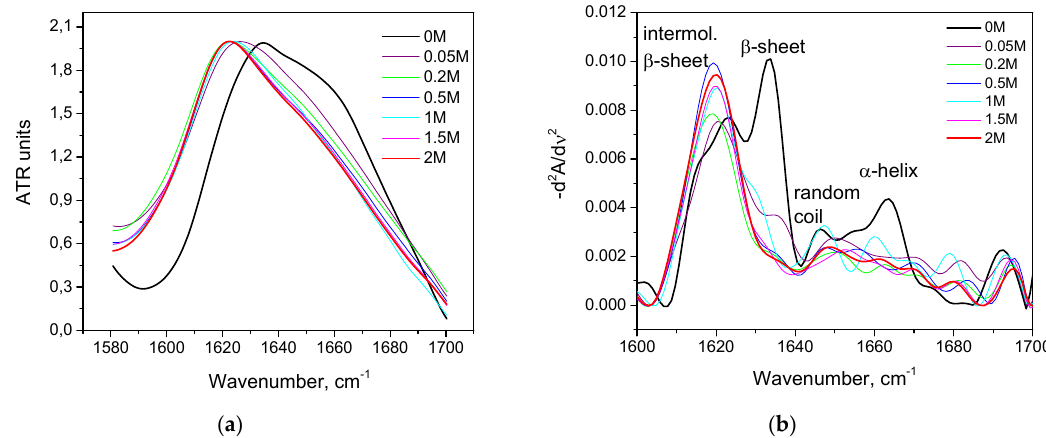
Figure 13. Changes in the character of the Amide I band ( a ) and changes in the second derivative of the Amide I band ( b ) of trypsin in 20% wt. aqueous solution at 80 °C with various concentrations of KSCN.